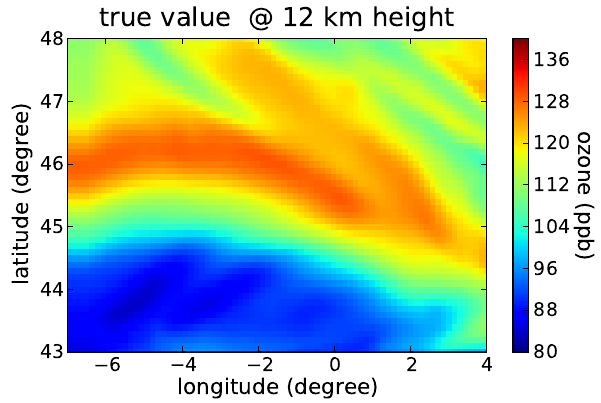
Fig. 2. The atmospheric situation. This figure depicts the ozone concentration of the true atmospheric state.